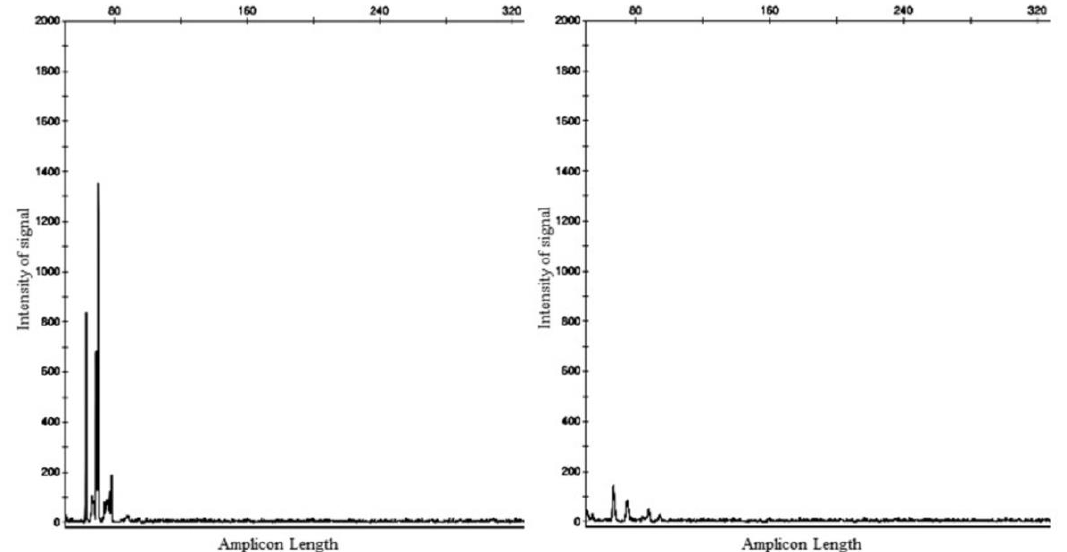
Figure 3. Molecular clonality analysis performed on DNA extracted from paraffin blocks using ca- pillary electrophoresis in the 3500 Genetic Analyzer (Applied Biosystems ® ). Results show clonal amplification with a 55 – 82 bp peak of the T- cell receptor (TCRγ) on the lower left and negative or poor amplification for the B-cell receptor (IgH) on the lower right after using the PARR technique protocol. The x-axis is the length of the amplicon, and the y-axis is the intensity of the